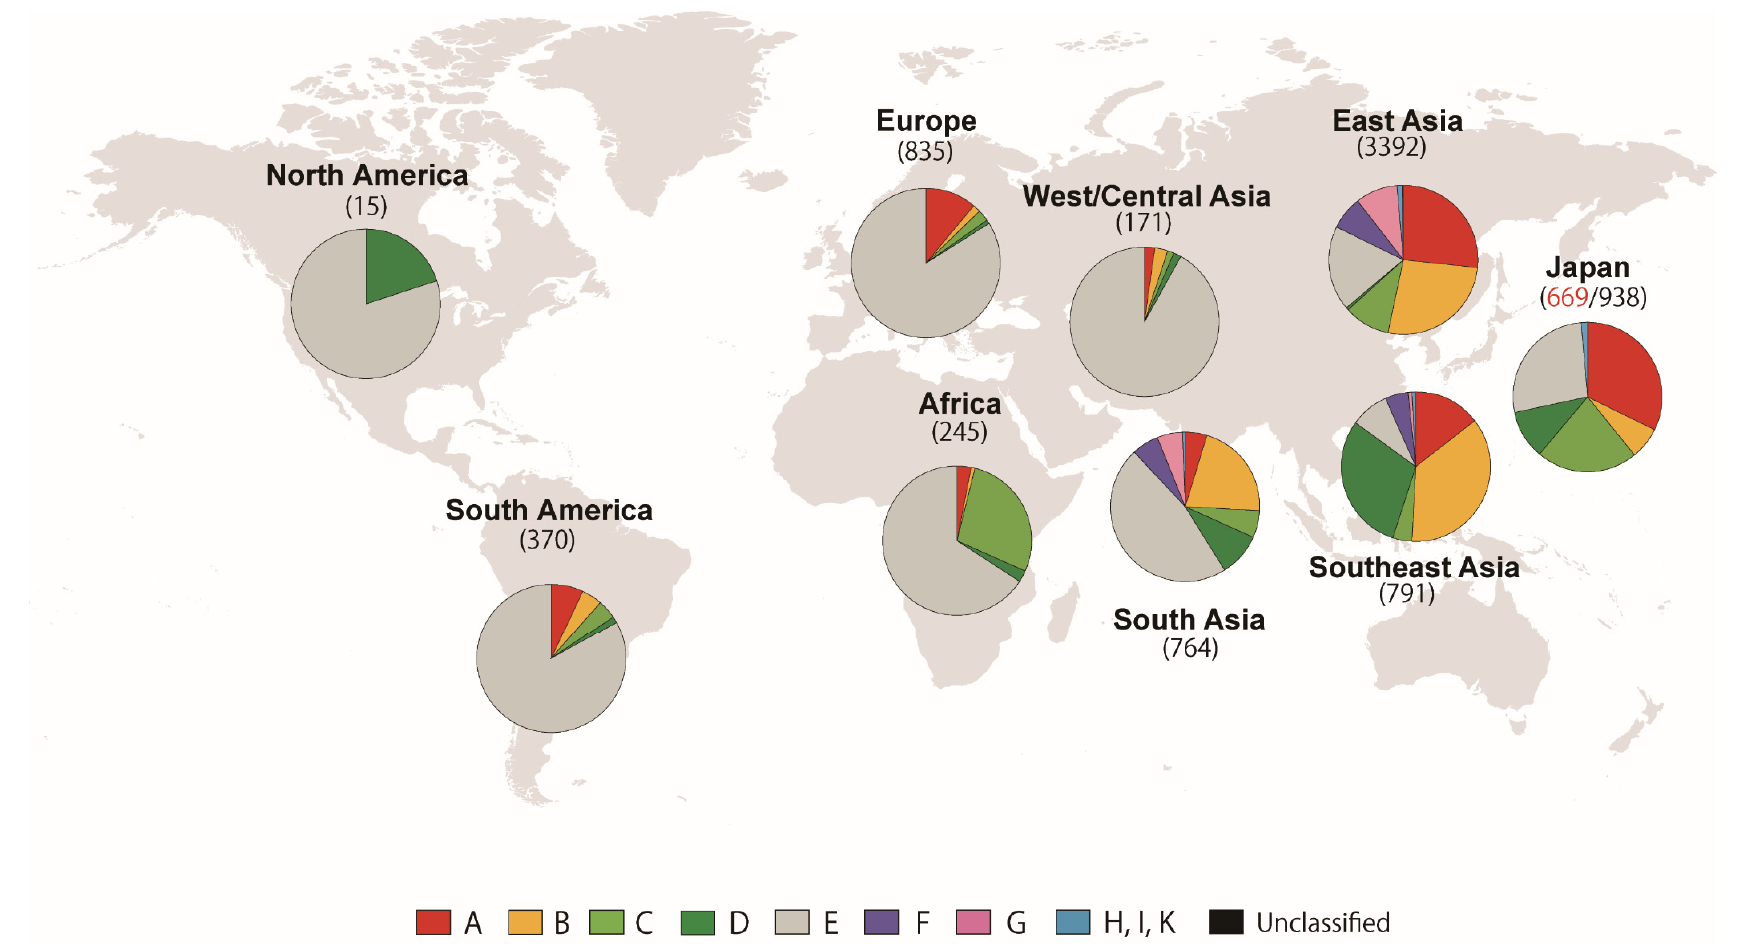
Figure 2. Distribution of D-loop haplogroups worldwide inferred from 6795 D-loop sequences obtained from GenBank and 669 sequences of Japanese indigenous chickens obtained in this study. The frequencies of nine haplogroups (A, B, C, D, E, F, G, H/I/K, and unclassified) in nine regions of the world are shown by pie charts. The number of sequences in each region is indicated in parentheses.